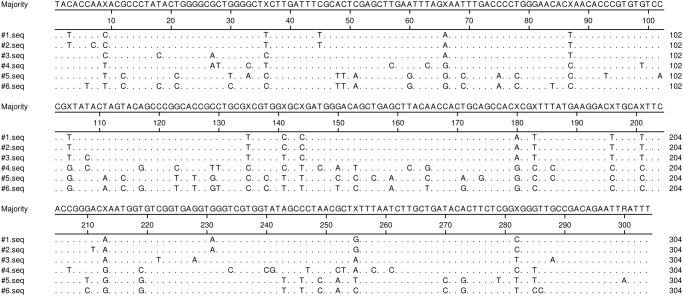
Sequence alignment.Comparison of a partial genome sequence in ORF2 from HEV positive samples. Dots indicate identity to the consensus sequence.